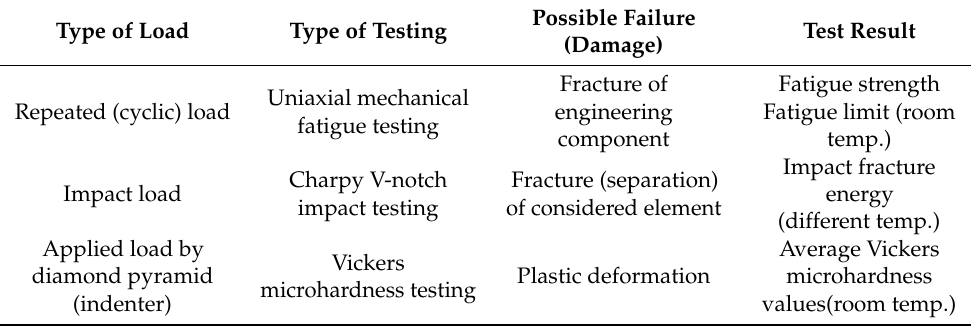
Table 7. Investigated materials: Load, testing, test results and possible